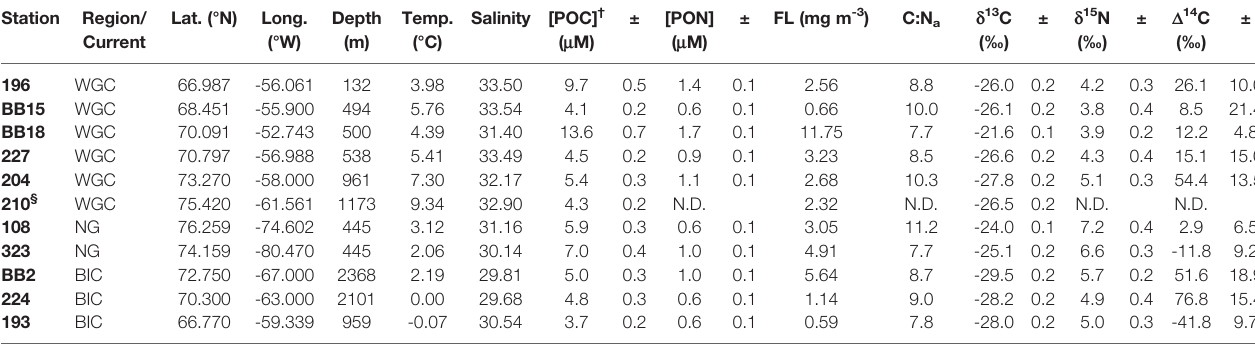
TABLE 1 | Summary of measured Baf fi n Bay hydrographic and POM data. Station Region/ Lat. (°N) Long. Current